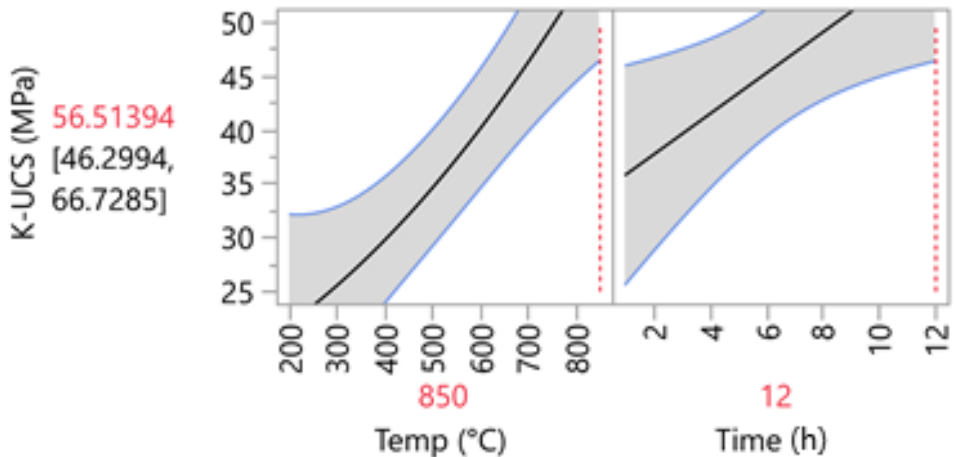
Figure 9. Interaction profile for time and temperature for K1-based samples.